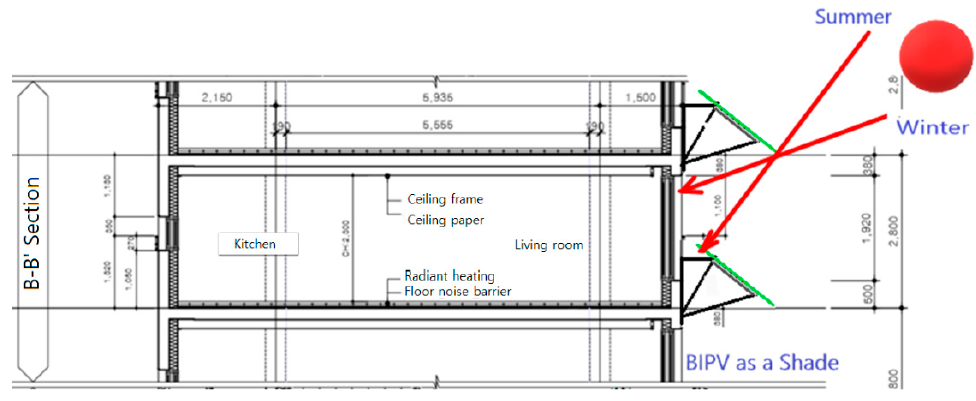
Figure 5. The concept of the MB-BIPVS for a section of the target apartment.